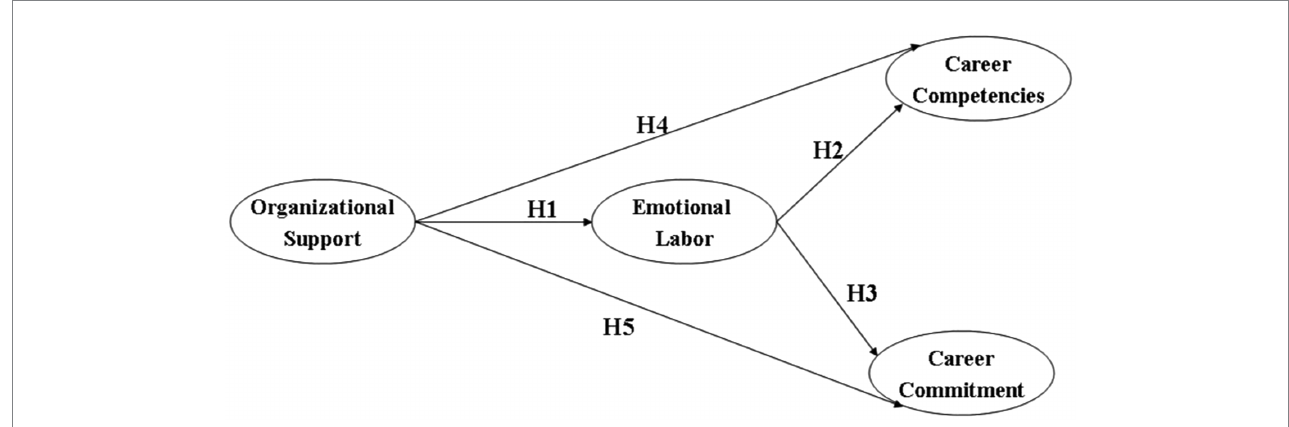
FIGURE 1 Conceptual